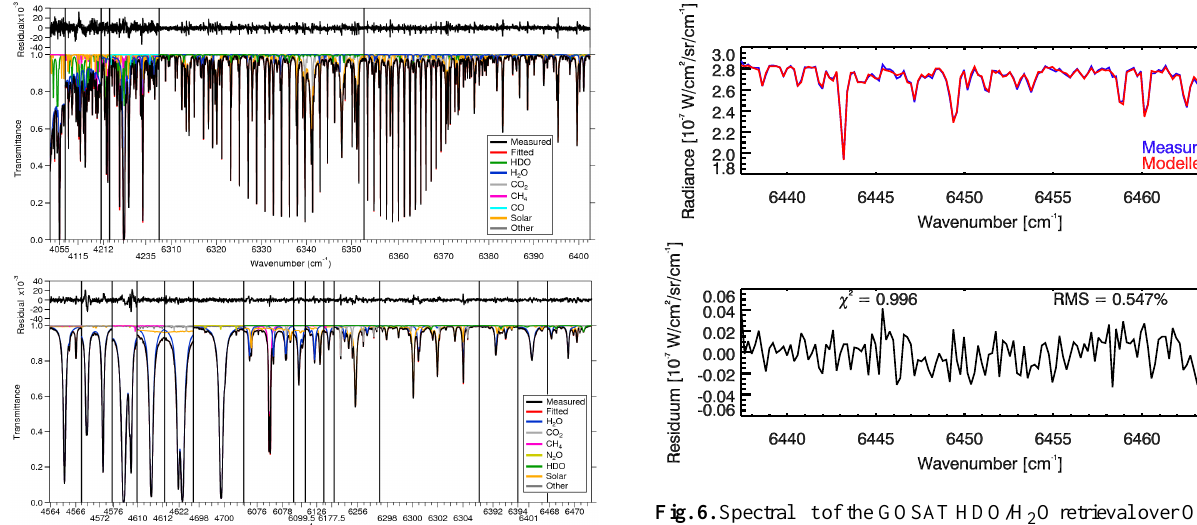
Fig. 6. Spectral fit of the GOSAT HDO/H 2 O retrieval over Orleans, France on 31 July 2010.